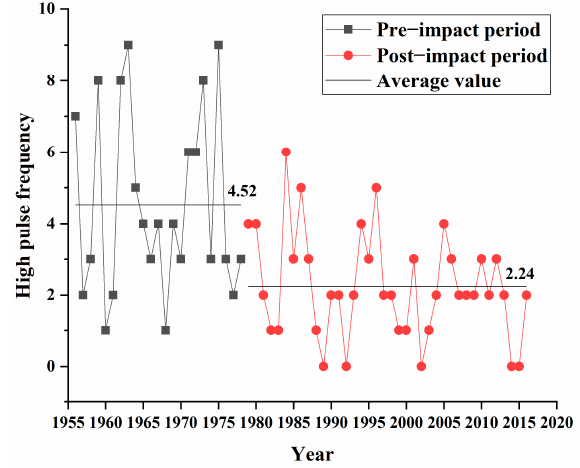
Figure 12. High pulse count.